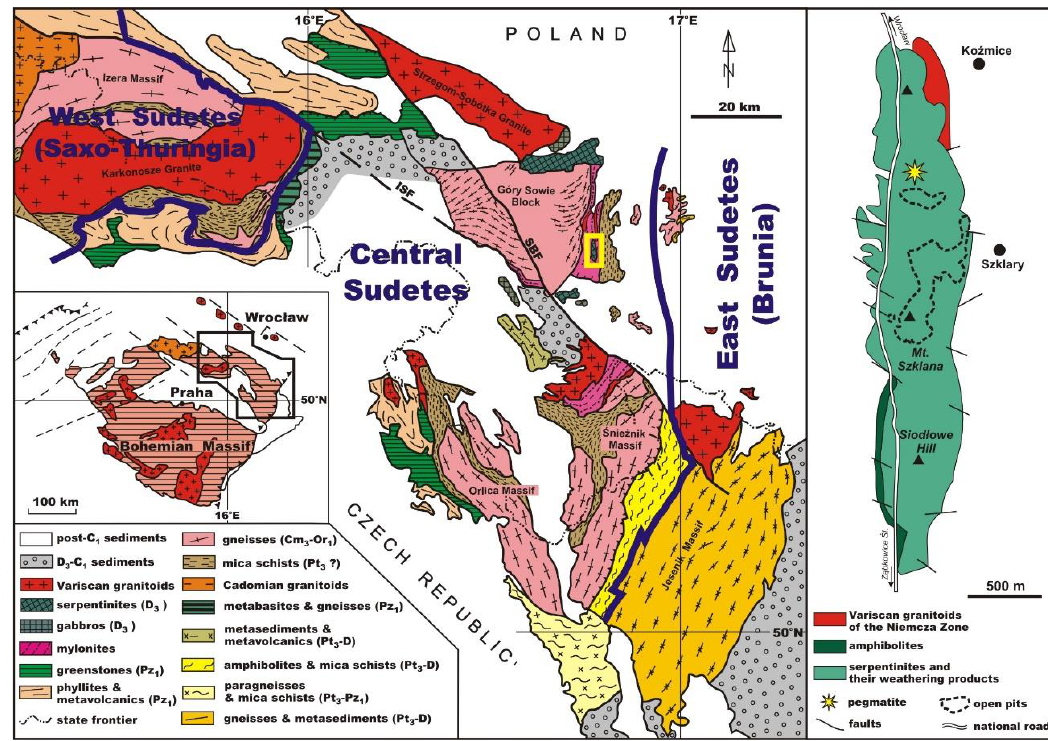
Figure 1. Geological sketch map of the Sudetes and its position in the Bohemian Massif (after [10], simplified). Yellow rectangle marks the position of the Szklary Massif. The right inlet shows the geology of the Szklary Massif with the location of the Szklary pegmatite (after [30], modified). Abbreviations: ISF—Intra Sudetic Fault, SBF—Sudetic Boundary Fault.